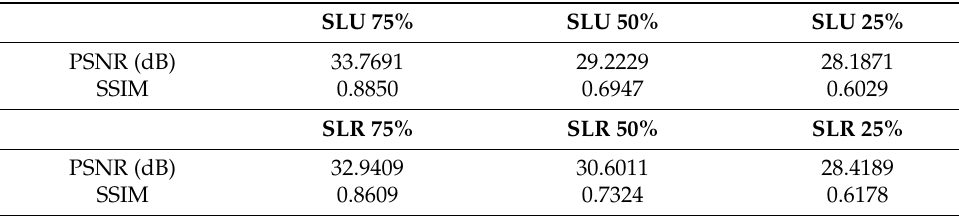
Table 2. PSNR and